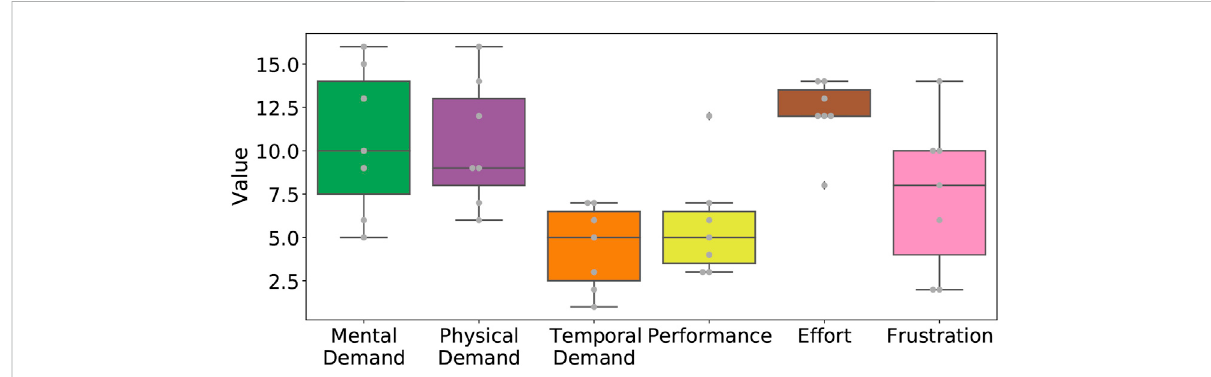
FIGURE 8 Boxplot with overlaid beeswarm plot of the reported NASA-TLX results.